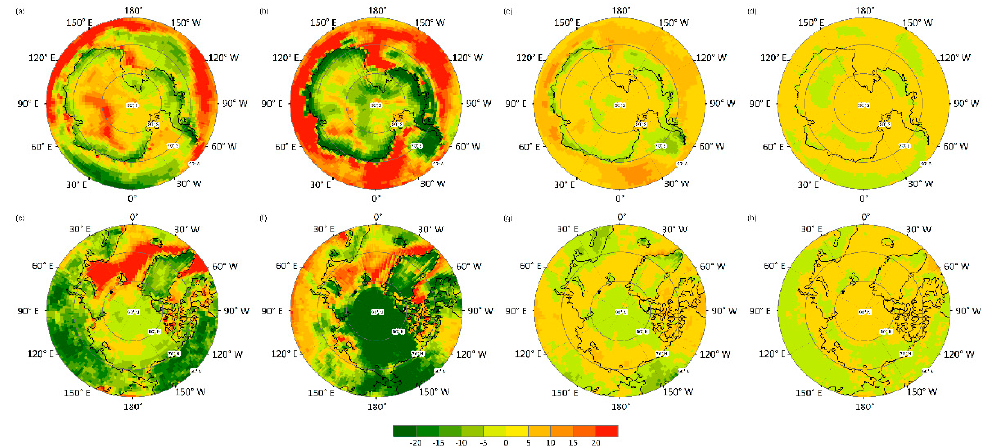
Figure 9. Seasonal geographical distribution of the different values between the SMA results and the CERES EBAF retrievals from 2000 to 2005. ( a )–( d ) and ( e )–( f ) are in local spring, summer, fall, and winter in the South and Northern Hemispheres, respectively (in units of W m -2 ).